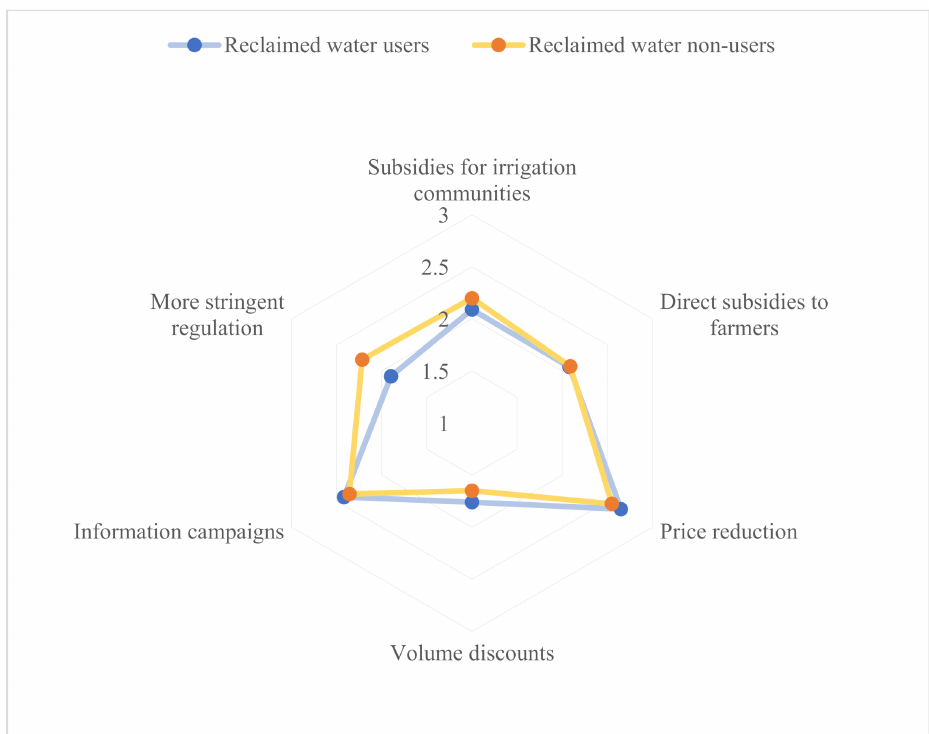
Figure 8. Farmers’ perceived effectiveness about different measures to boost reclaimed water